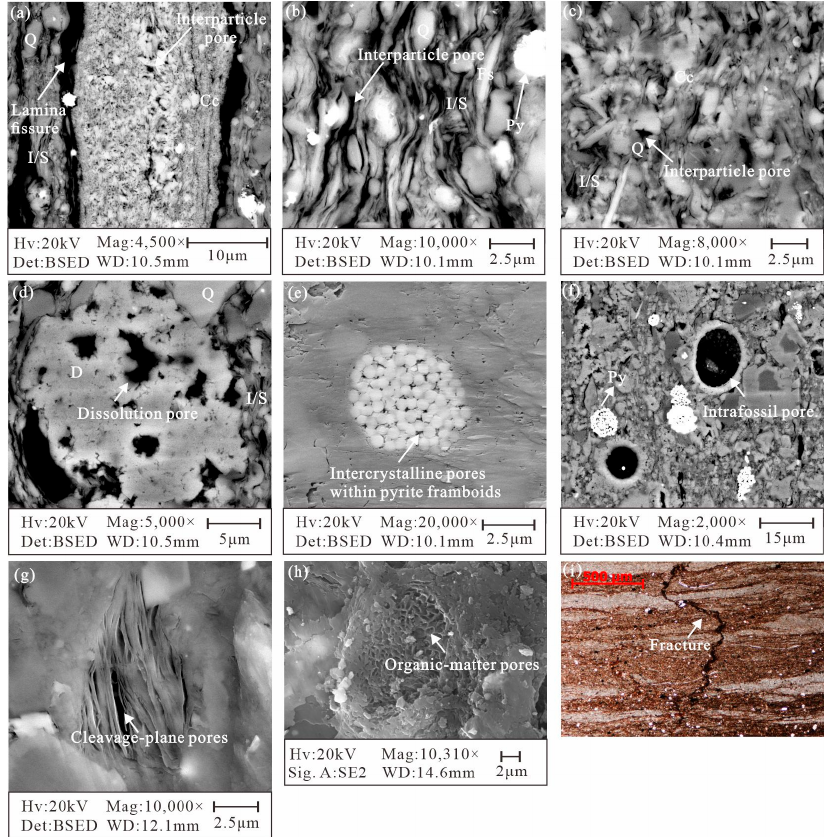
Figure 7. ( a ) Interparticle pores in carbonate laminae. Well GX 27, 2313.75 m. ( b ) Interparticle pores in clay laminae, Well GX27, 2311.53 m. ( c ) Interparticle pores in massive rocks. Well GX27, 2303.18 m. ( d ) Dissolution pores in dolomite. Well GX27, 2317.29 m. ( e ) Intercrystalline pores within pyrite framboids. Well NY1, 3454.4 m. ( f ) Intrafossil pores. Well GX 27, 2300.91 m. ( g ) Cleavage-plane pores within clay grains. Well NX55, 3787.56 m. ( h ) Organic-matter pores. Well N55X1, 3572.98 m. ( i ) Fractures. Well NY1, 3443.55 m.